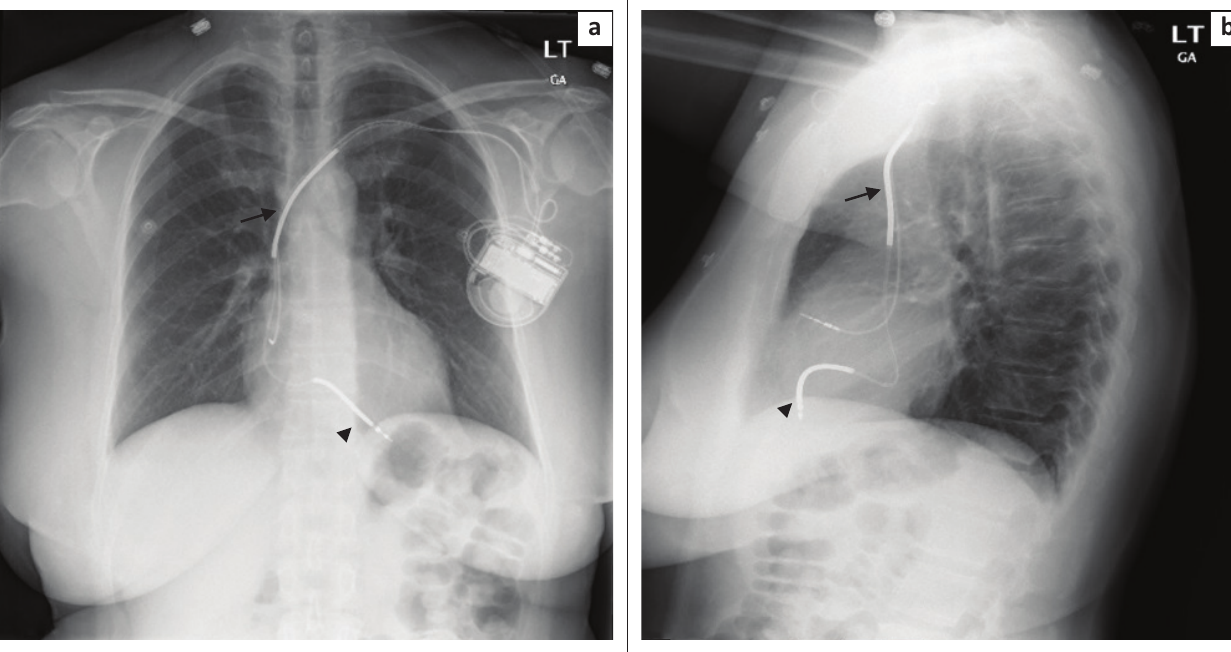
FIGURE 5: Chest radiographs posterior–anterior (a) and lateral views (b) showing a dual-lead implantable cardioverter defibrillator with its characteristic shock coils implanted in a 62-year-old female patient with non-ischaemic